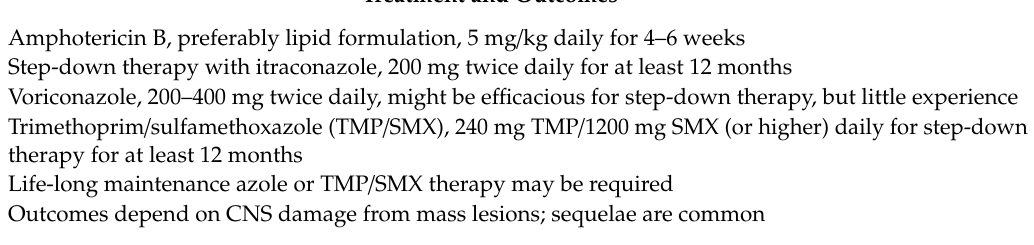
Table 2. Salient Points Regarding Central Nervous System (CNS)